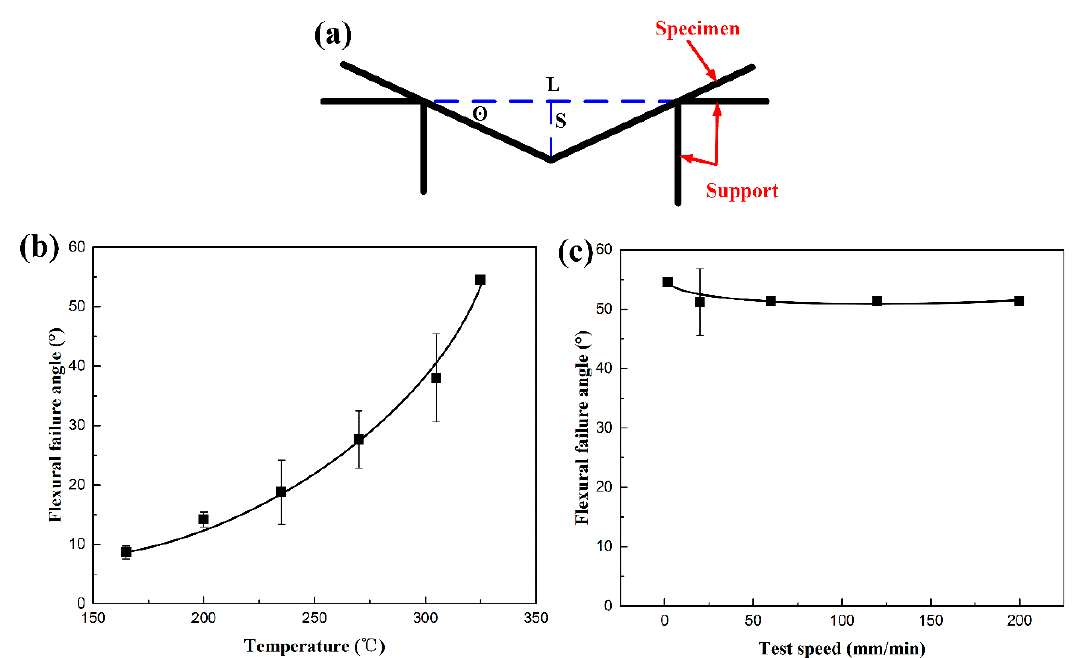
Figure 7. Relationship between flexural failure angle and deformation condition of woven CF / PEEK composites: ( a ) schematic diagram of flexural failure angle, ( b ) the relationship between failure angle and deformation temperature, and ( c ) the relationship between failure angle and deformation speed.